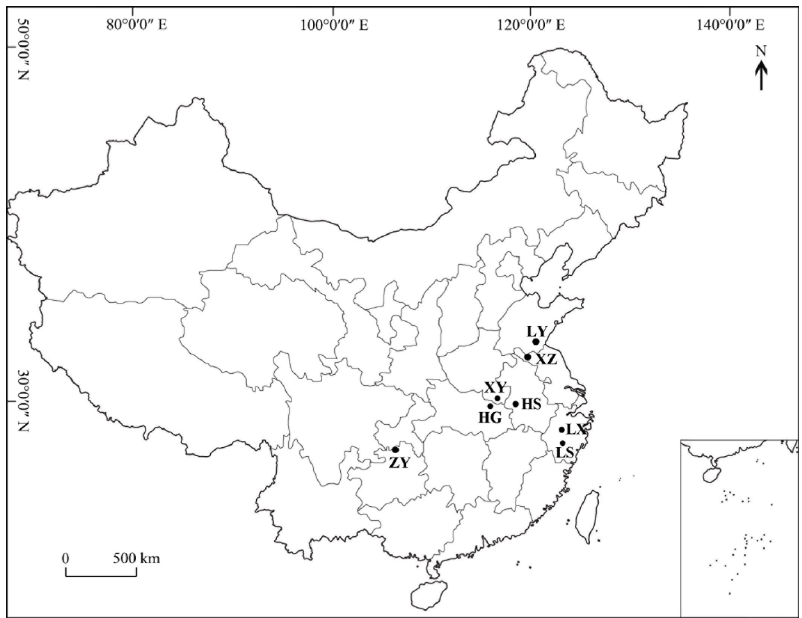
Figure 1. Geographical distribution map of the eight T. sebifera (Linnaeus) populations. Table 1. The origins of the eight T. sebifera (Linnaeus) populations.